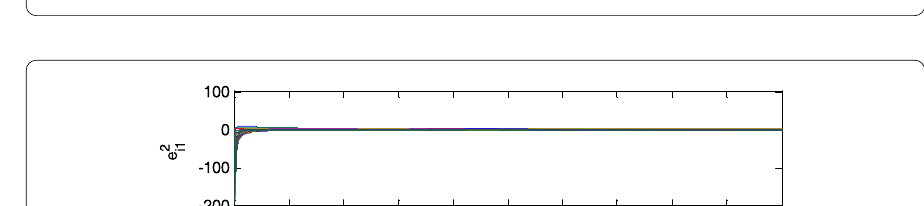
Figure 3 Trajectories of the error system (8) about G 1